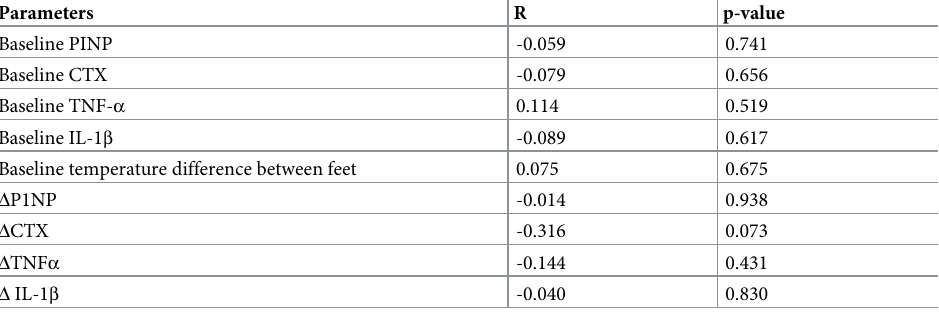
r value obtained by Pearson correlation analysis.